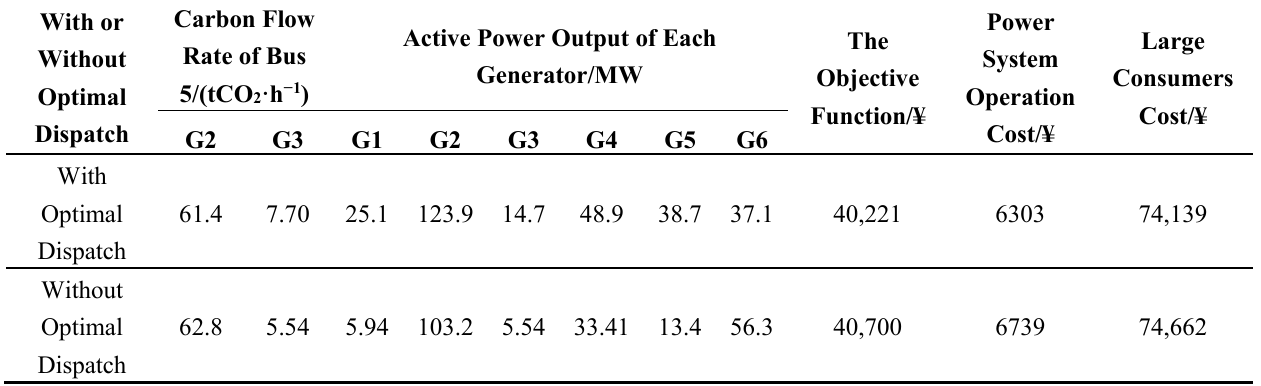
Table 3. The results with or without optimal